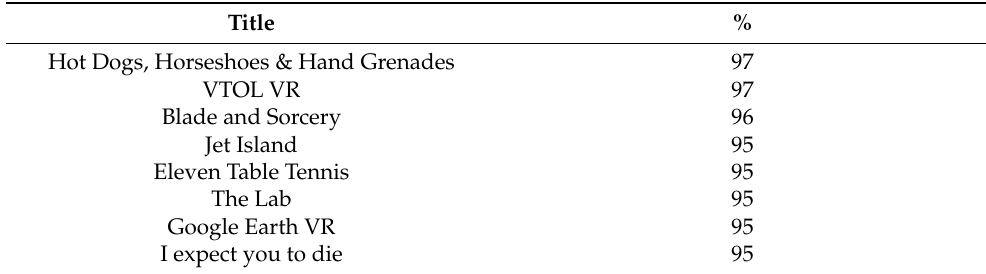
Table 9. VR applications with “overwhelmingly positive” reviews in the category of simulation VR apps [state on 6 July